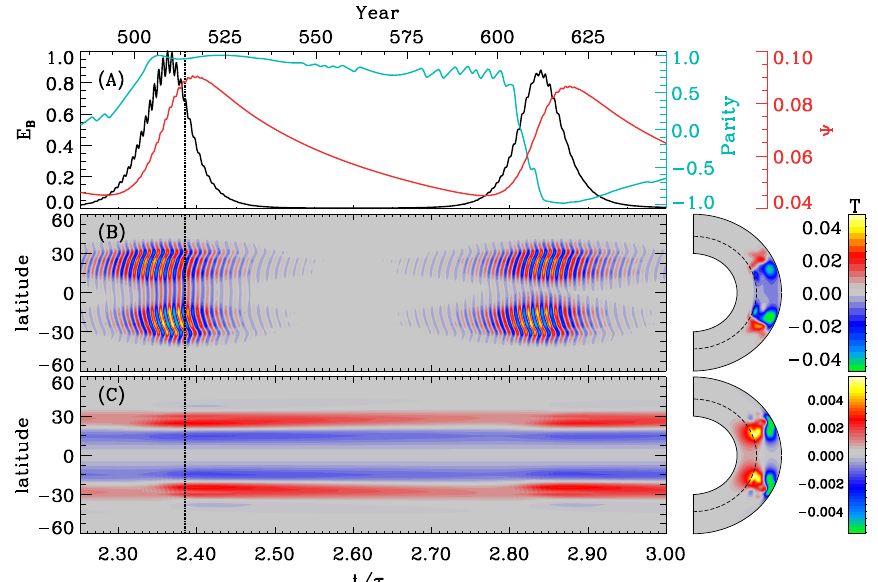
Fig. 6. Identical in format to Figure 4, but showing now a very low Pm solution (Pm = 5 (cid:2) 10 (cid:3) 3 ; solution run 3 in Table 1).